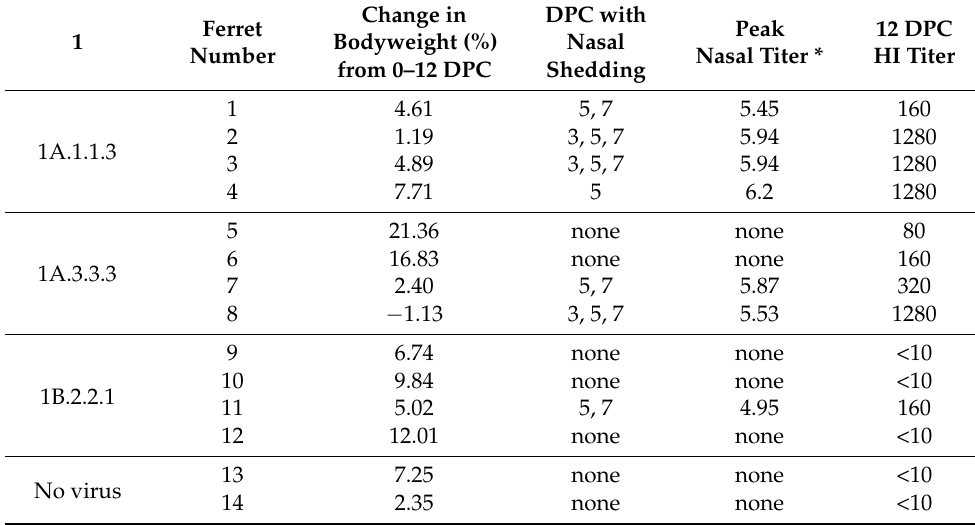
Table 4. Cumulative clinical, viral, and serological measures of ferret